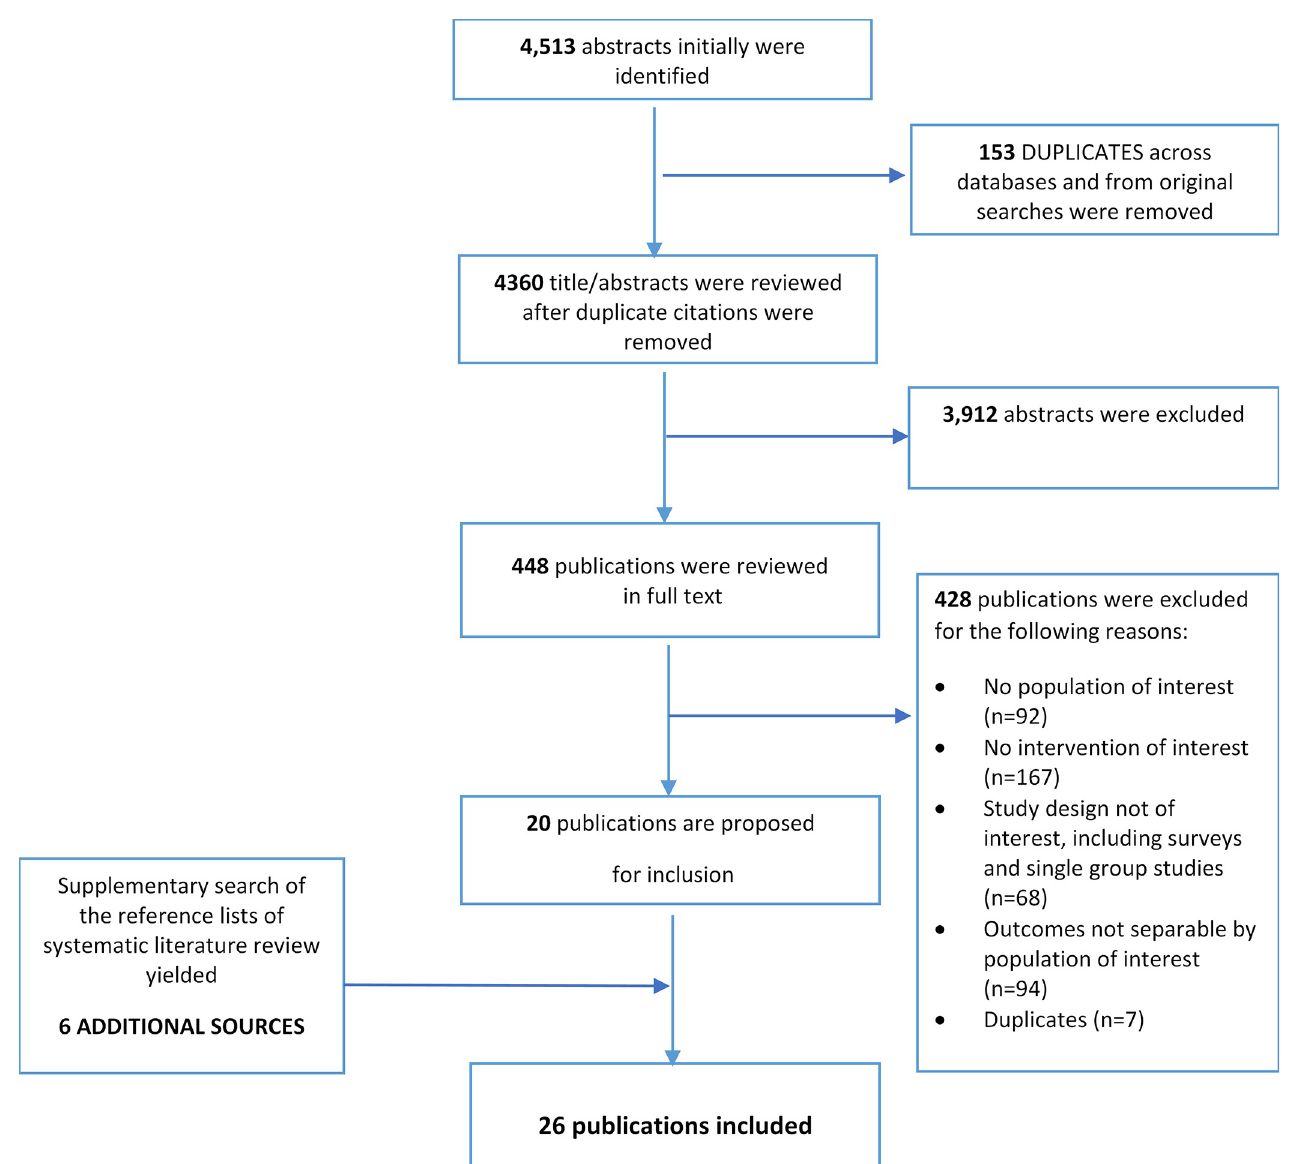
Fig 1. Overview of the systematic literature search: PRISMA flow chart. Using a standardized data extraction form, the mean change and standard deviation of outcome measures within the intervention and comparator groups were extracted and validated accordingly for additional quality assurance. Studies published in multiple articles were extracted as one study. A risk-of-bias assessment for included publications was undertaken by independent reviewers using a checklist developed by the Cochrane Collaboration, the Risk of Bias in Non-Randomized Studies of Interventions (ROBINS-I) tool for non-interventional studies [15]. The seven domains used in the ROBINS-I tool determine the strength of evidence/risk of bias due to confounders, participant selection, classification of interventions, deviations from intended interventions, missing data, measurement of outcomes, and selection of the reported results. A three- point Likert scale was applied to score the bias from low to serious for each of the seven domains; this was later validated by a second reviewer.